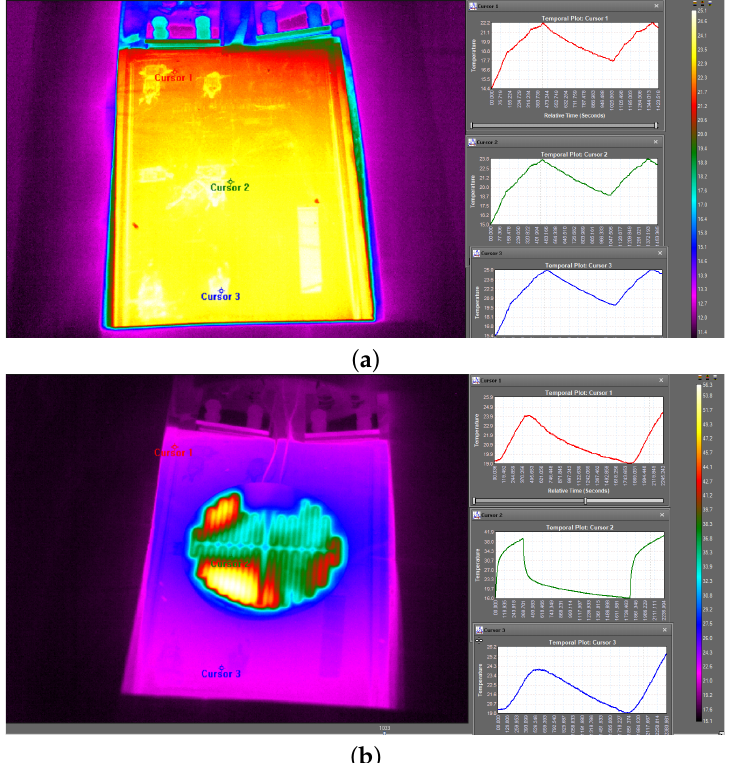
Figure 6. Infrared (IR) images for ( a ) internal and ( b ) external preheat